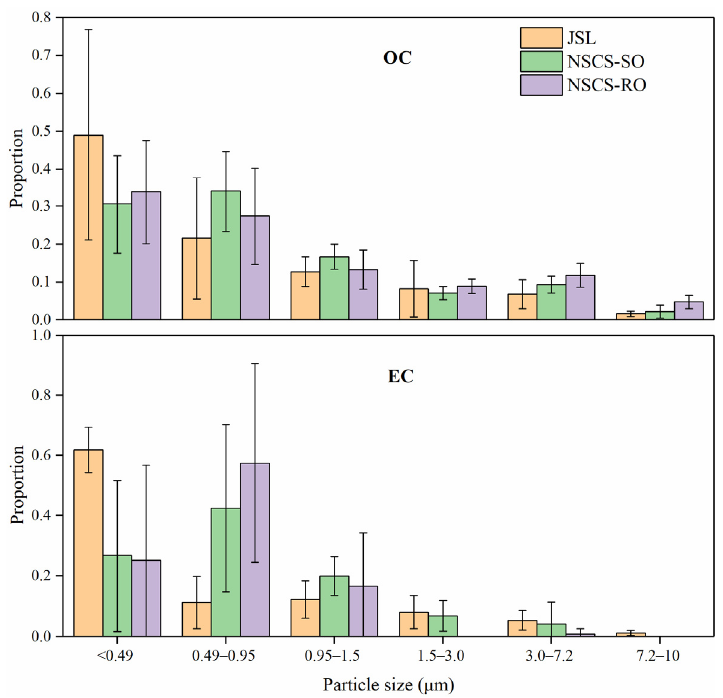
Figure 4. The relative abundance of OC and EC in each size fraction (the error bar represents the standard deviation).